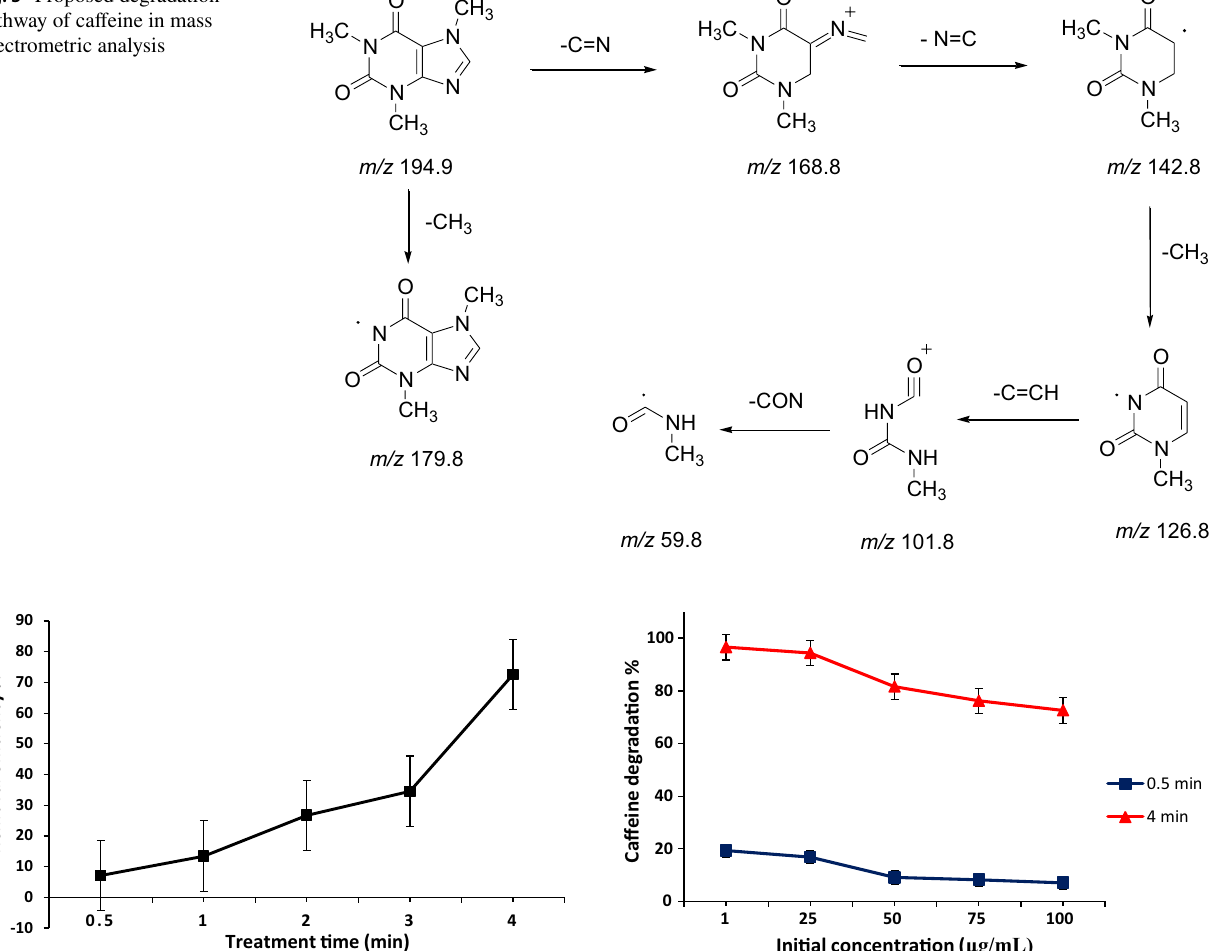
Fig. 3 Proposed degradation pathway of caffeine in mass spectrometric analysis